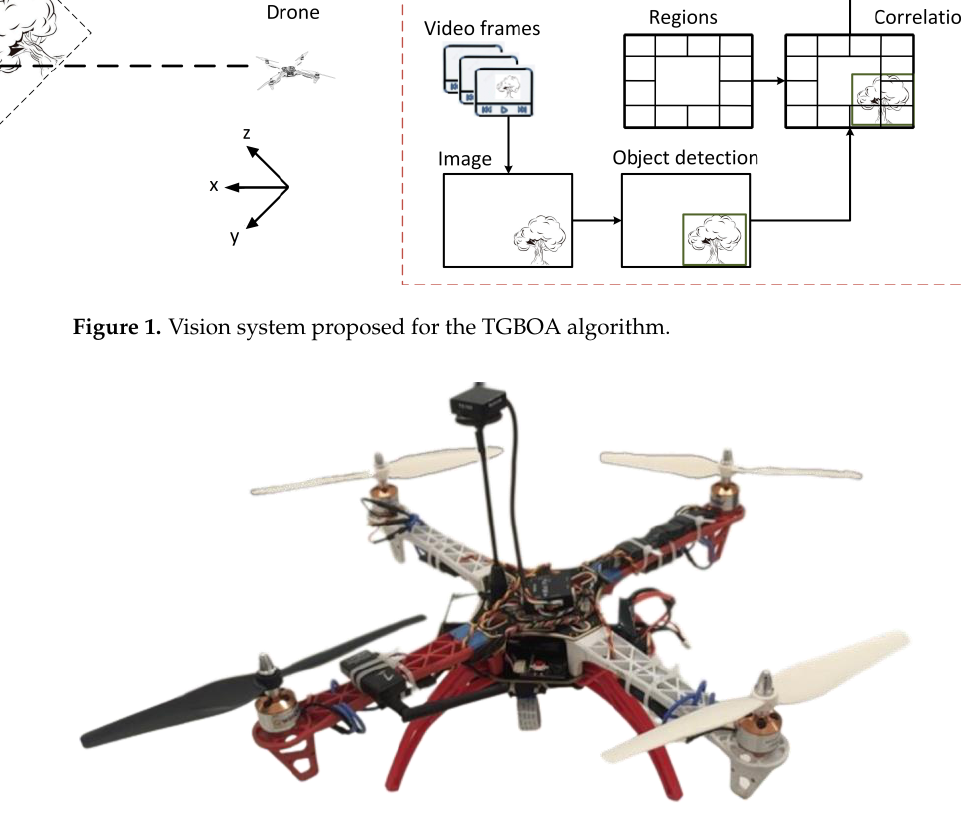
Figure 2. Quadcopter F − 450.